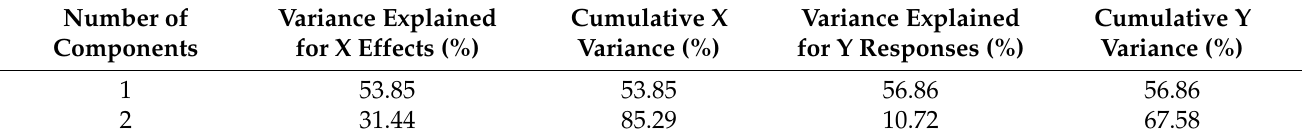
Table 2. Cross validation of the PLS model for Kenics static mixers with an eccentricity factor.